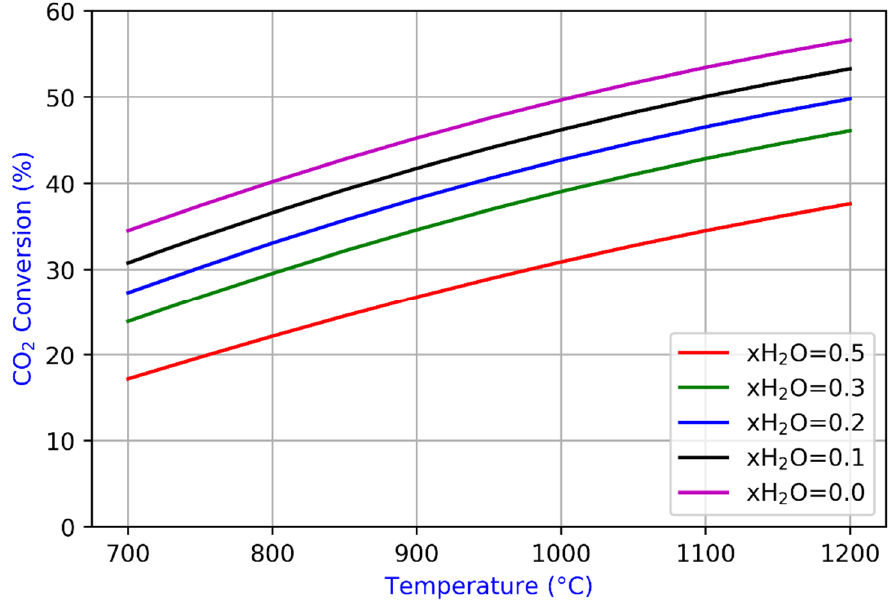
Figure7. EffectoftemperatureandH 2 OconcentrationonCO 2 conversioninRWGSreaction.Higherreaction Figure 7. Effect of temperature and H 2 O concentration on CO 2 conversion in RWGS reaction. Higher temperature and lower H 2 O concentration results in higher CO 2 reaction temperature and lower H 2 O concentration results in higher CO 2 conversions.